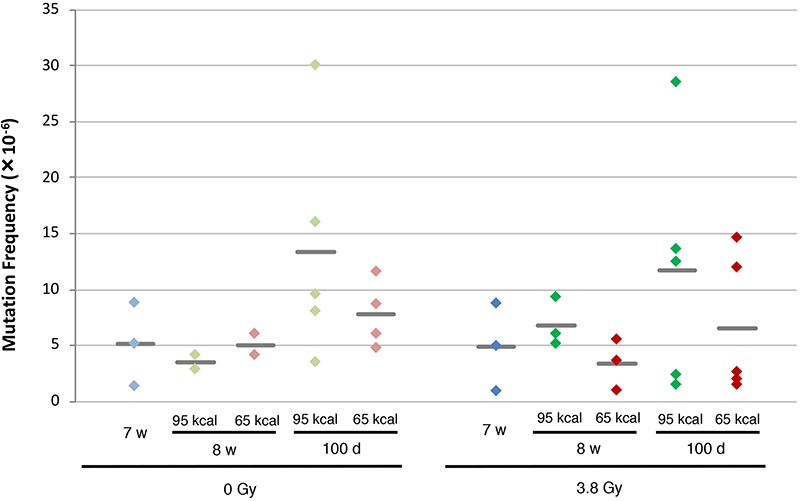
Mutation frequency at the gpt gene in the spleen of gpt delta mice. The results presented in Table 1 are plotted. Diamonds (green: 95 kcal/week; red: 65 kcal/week) represent the frequency for an individual mouse, and grey bars represent the average frequencies for the groups.